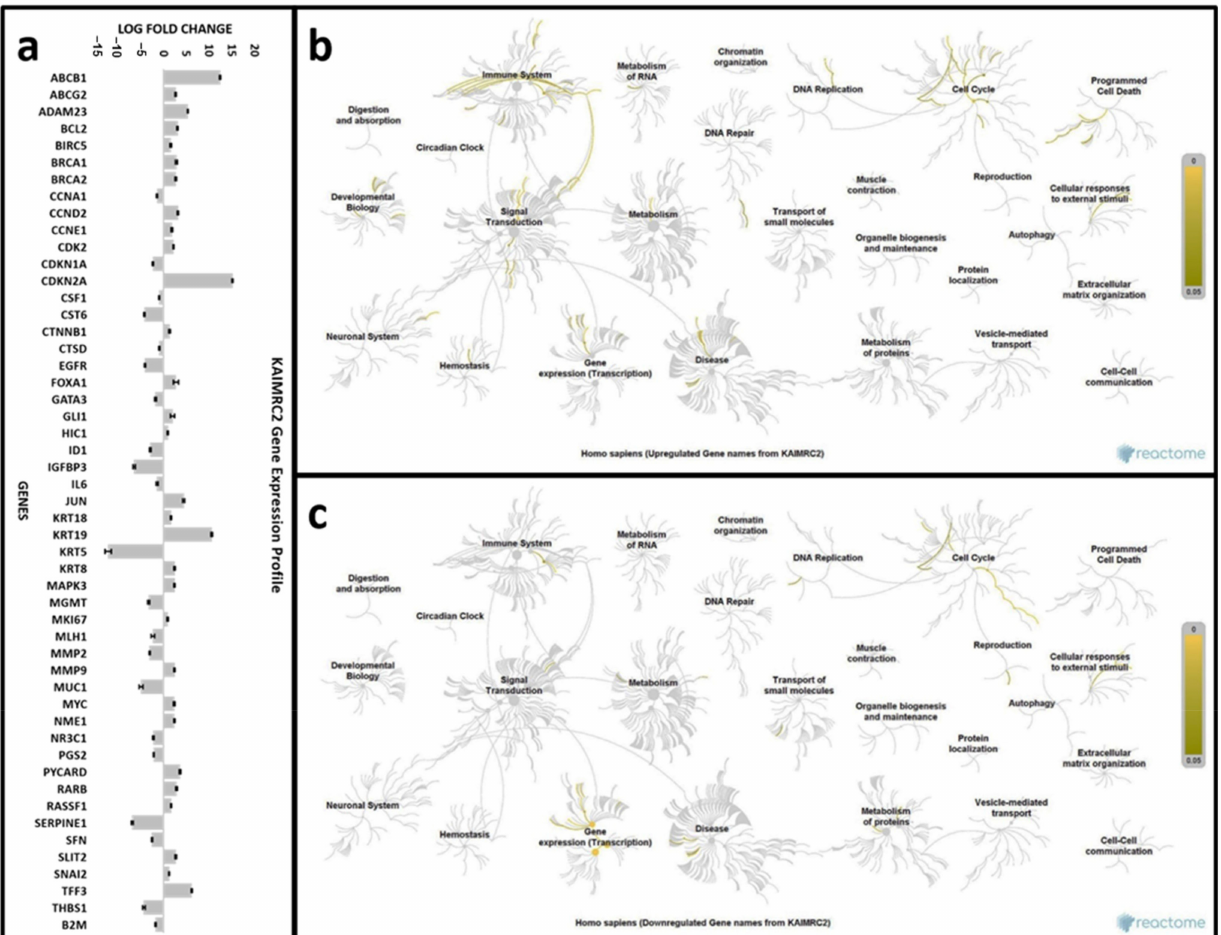
Figure 4. Gene Expression Analysis of breast cancer KAIMRC2 cell line. ( a ) Relative up- or downregulation of key genes of KAIMRC2 cells is presented. Each column represents a single gene and represents data from duplicates. ( b , c ) Segregation of the identified genes into up- and downregulated genes. The web-based freely available pathway analysis tool, Reactome Pathway database (reactome.org), was used to identify the pathways affected by these